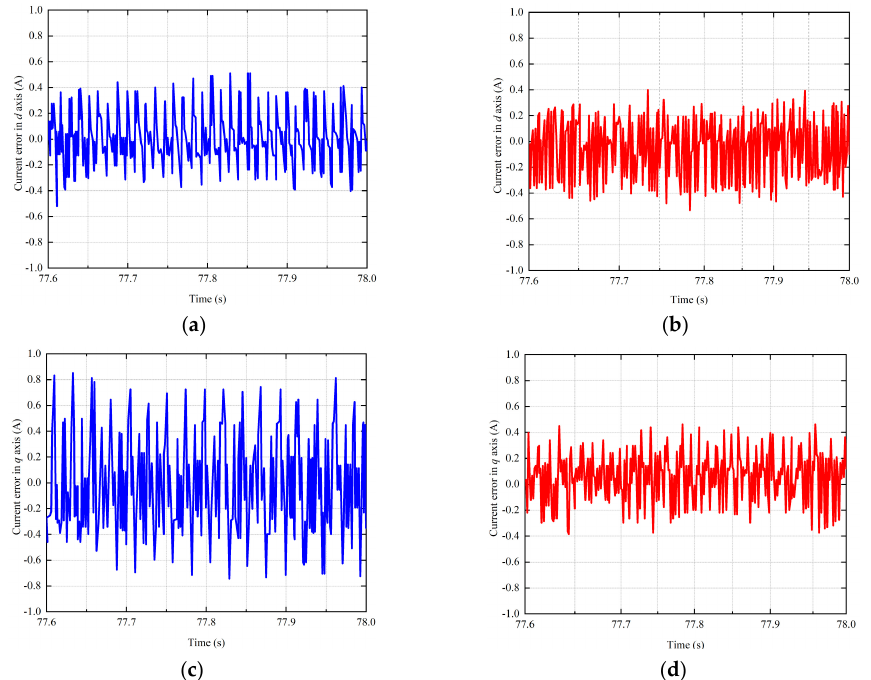
⋅ m load. ( a ) Current error in